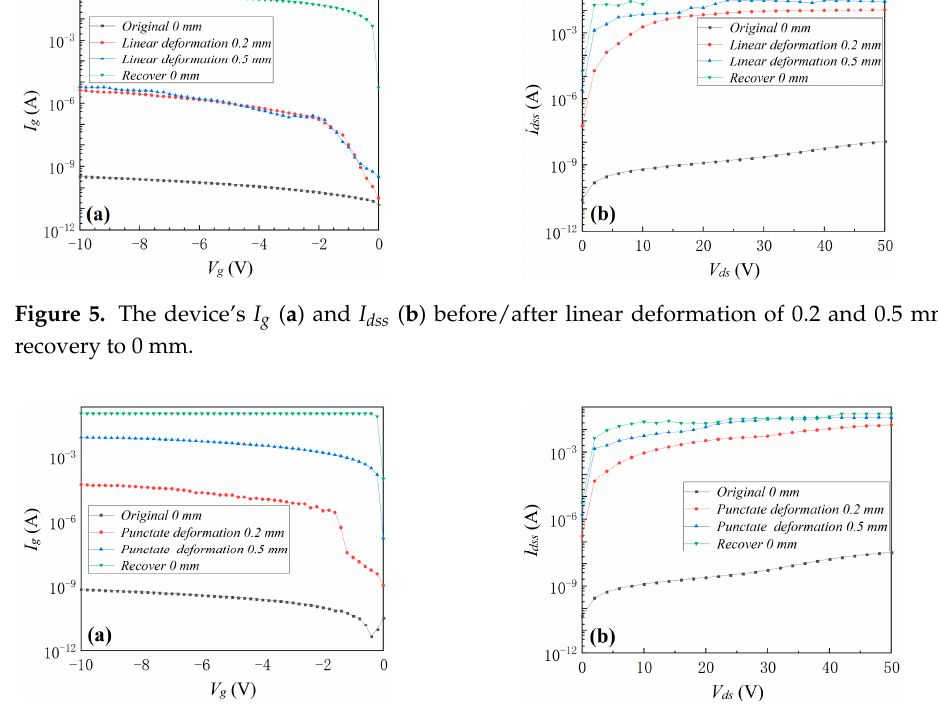
Figure 6. The device’s I g ( a ) and I dss ( b ) before/after punctate deformation of 0.2 and 0.5 mm and recovery to 0.